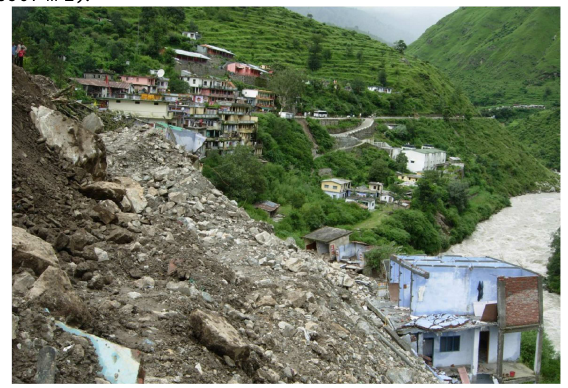
Figure 2. Photograph of a active landslide in the study